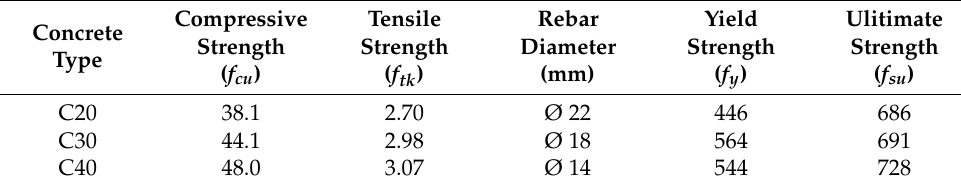
Table 4. Material properties of concrete and rebar (MPa).